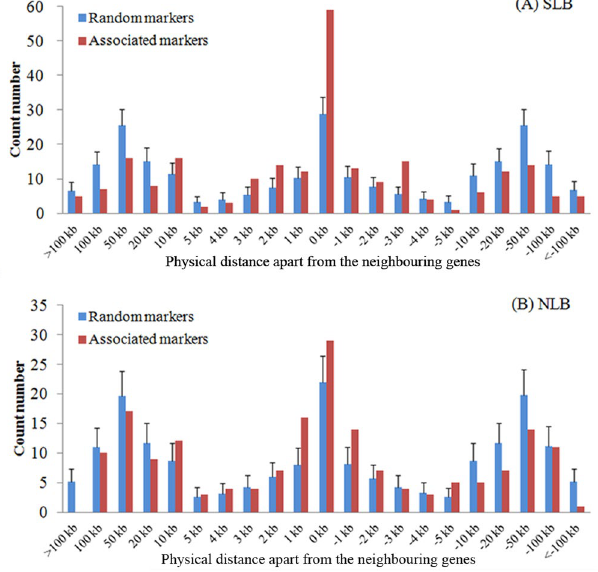
Figure 5. Genomic distribution test of associated markers on neighbouring genes. ( A ) SLB, and ( B ) NLB. In total, 236 SLB resistance associations and 182 NLB resistance associations were identified. The genomic distributions of the resistance associated markers on their neighbouring genes (red bars) were separately compared with a null distribution of random markers (blue bars). The null distribution was obtained by selecting an equivalent number of random markers from the applied 28.5 million marker set and calculating their proximity to different regions of their nearest genes, which was repeated 1000